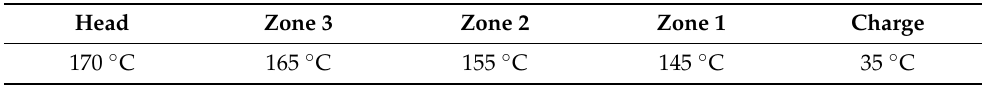
Table 4. Temperature of heating zones for a single-screw